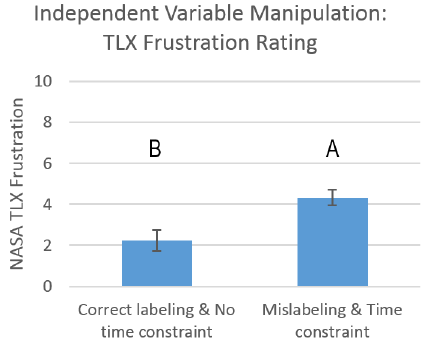
Figure 3. Mean and standard error of frustration ( n = 40).